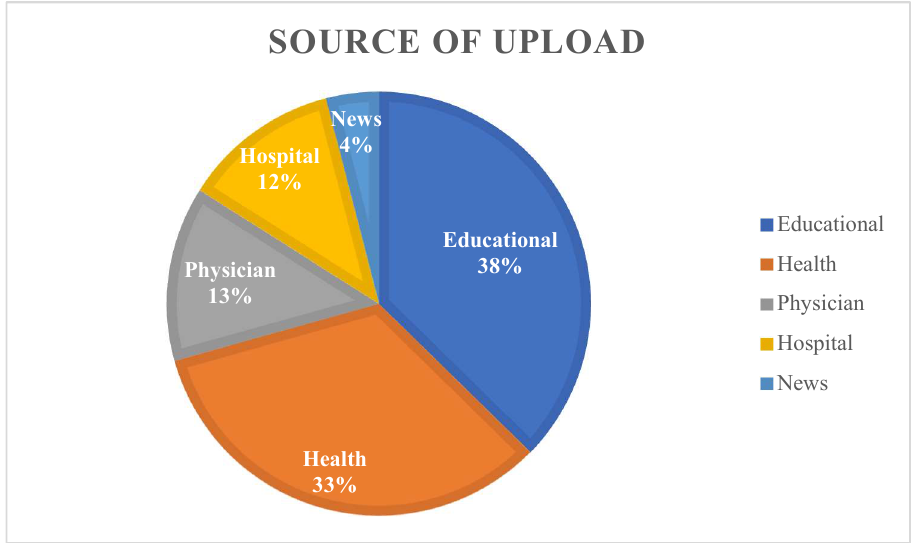
Figure 2. The diagram of sources of uploading. Table 5. The characteristics of videos according to source of uploading groups.